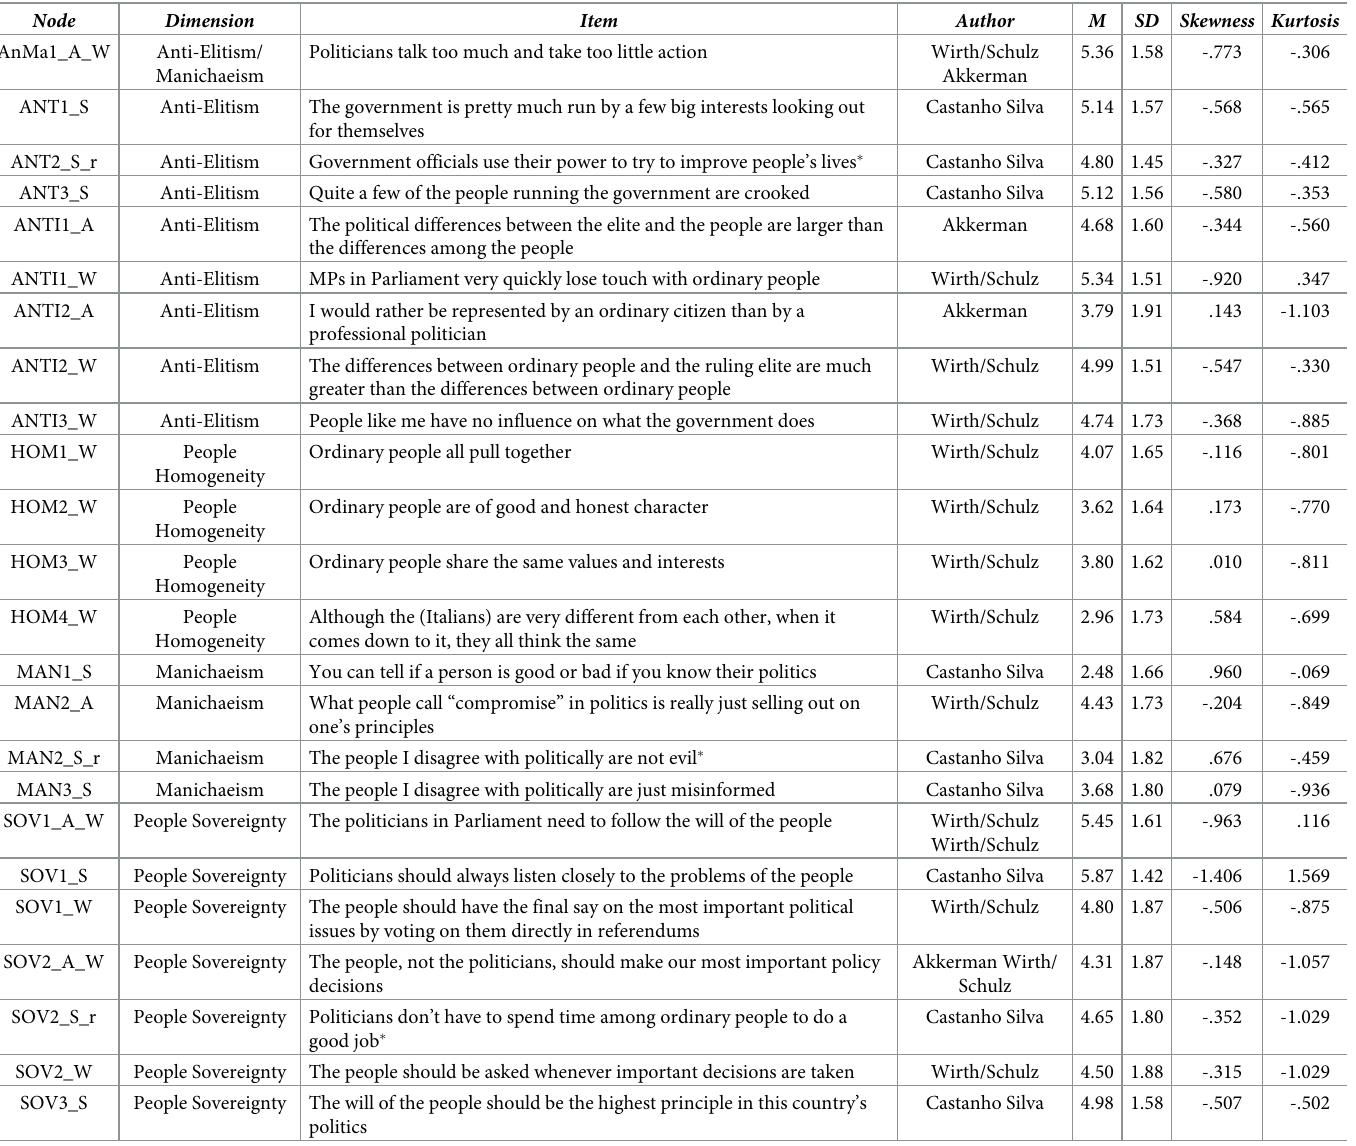
Table 2. Nodes’ labels and descriptive statistics of the initial network structure of populist